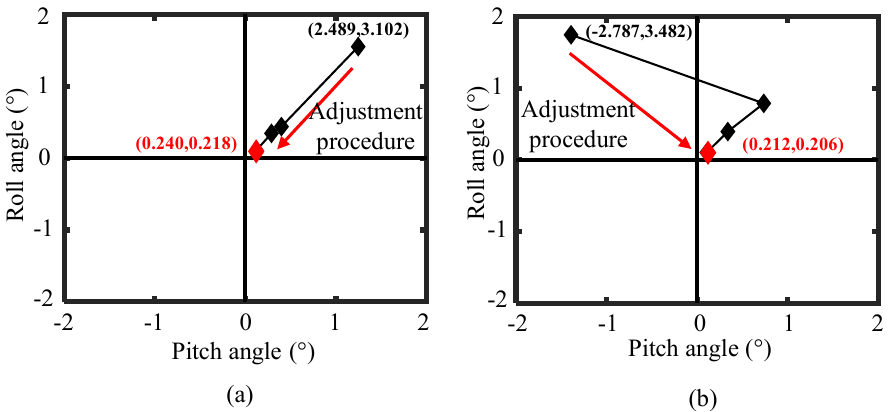
Figure 12. Experimental results of calibration of the lateral displacement gauge (probe A). ( a ) Hori- zontal calibration of the lateral displacement gauge (probe A); ( b ) vertical calibration of the lateral displacement gauge (probe A).